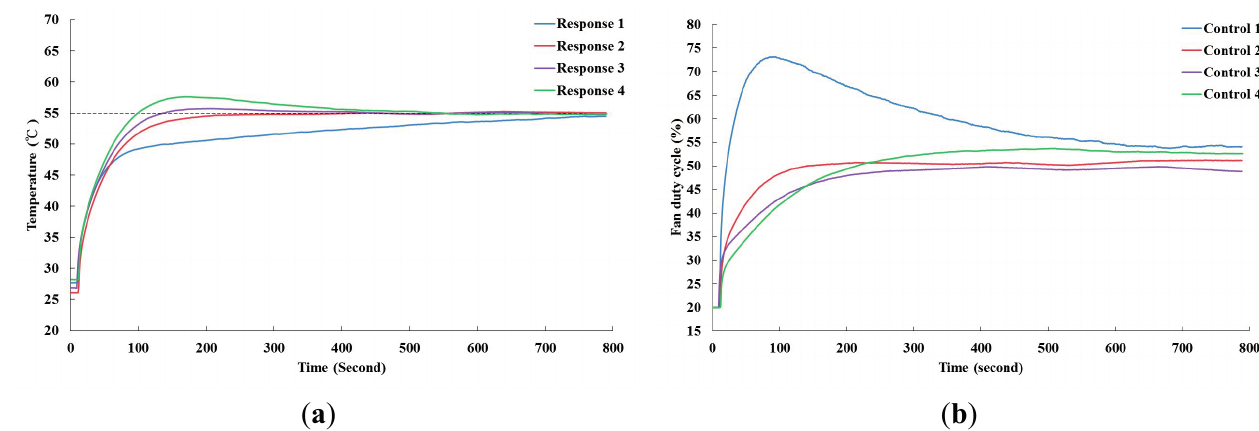
Figure 7. The result of PID self-tuning. ( a ) The process of P gain; ( b ) The process of I gain; ( c ) The process of D gain.